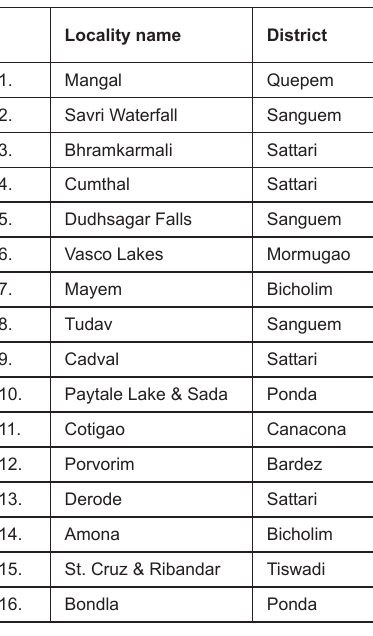
Table 1. Locality, associated habitats and number of